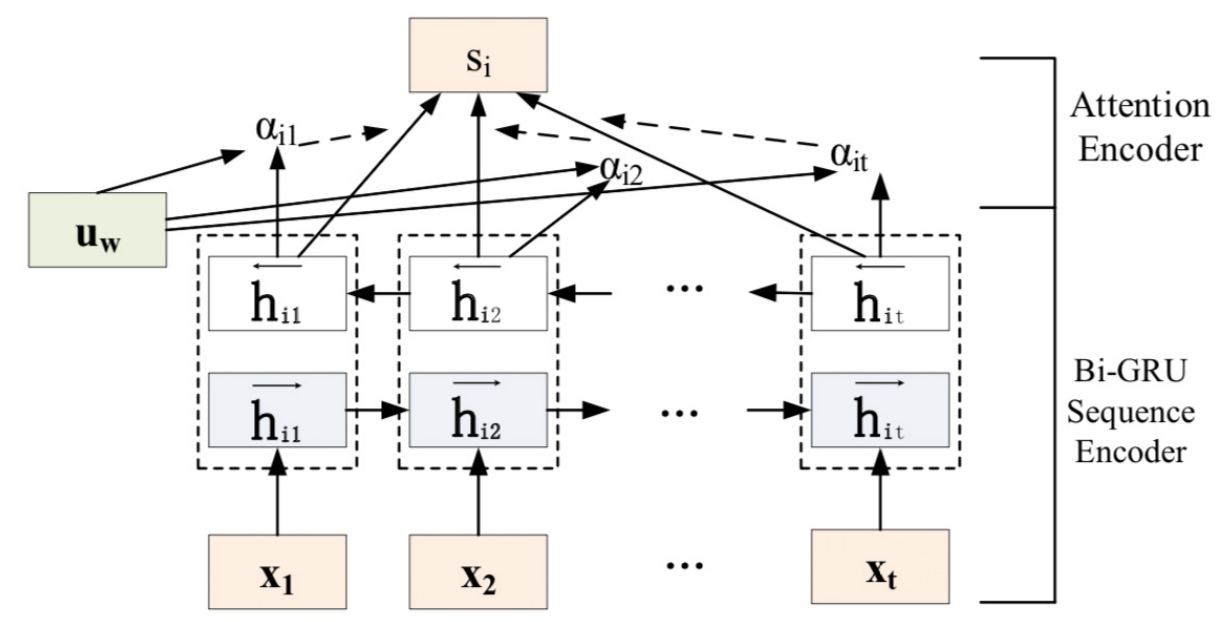
Figure 2. Document encoder